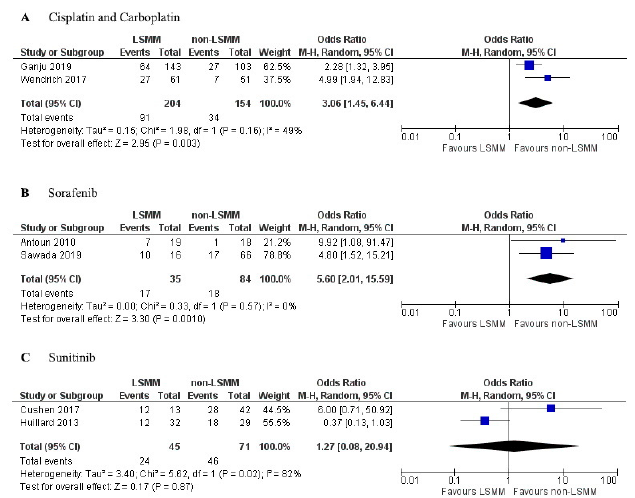
Figure 5. Forest plots for association between low skeletal muscle mass (LSMM) and toxicity specifically for monotherapies used in multiple studies. ( A ) includes patients treated with cisplatin or carboplatin as a monotherapy; ( B ) includes patients treated with sorafenib as monotherapy; ( C ) includes patients treated with sunitinib as monotherapy. For each forest plot, the combined effect of the studies is plotted with a black diamond.